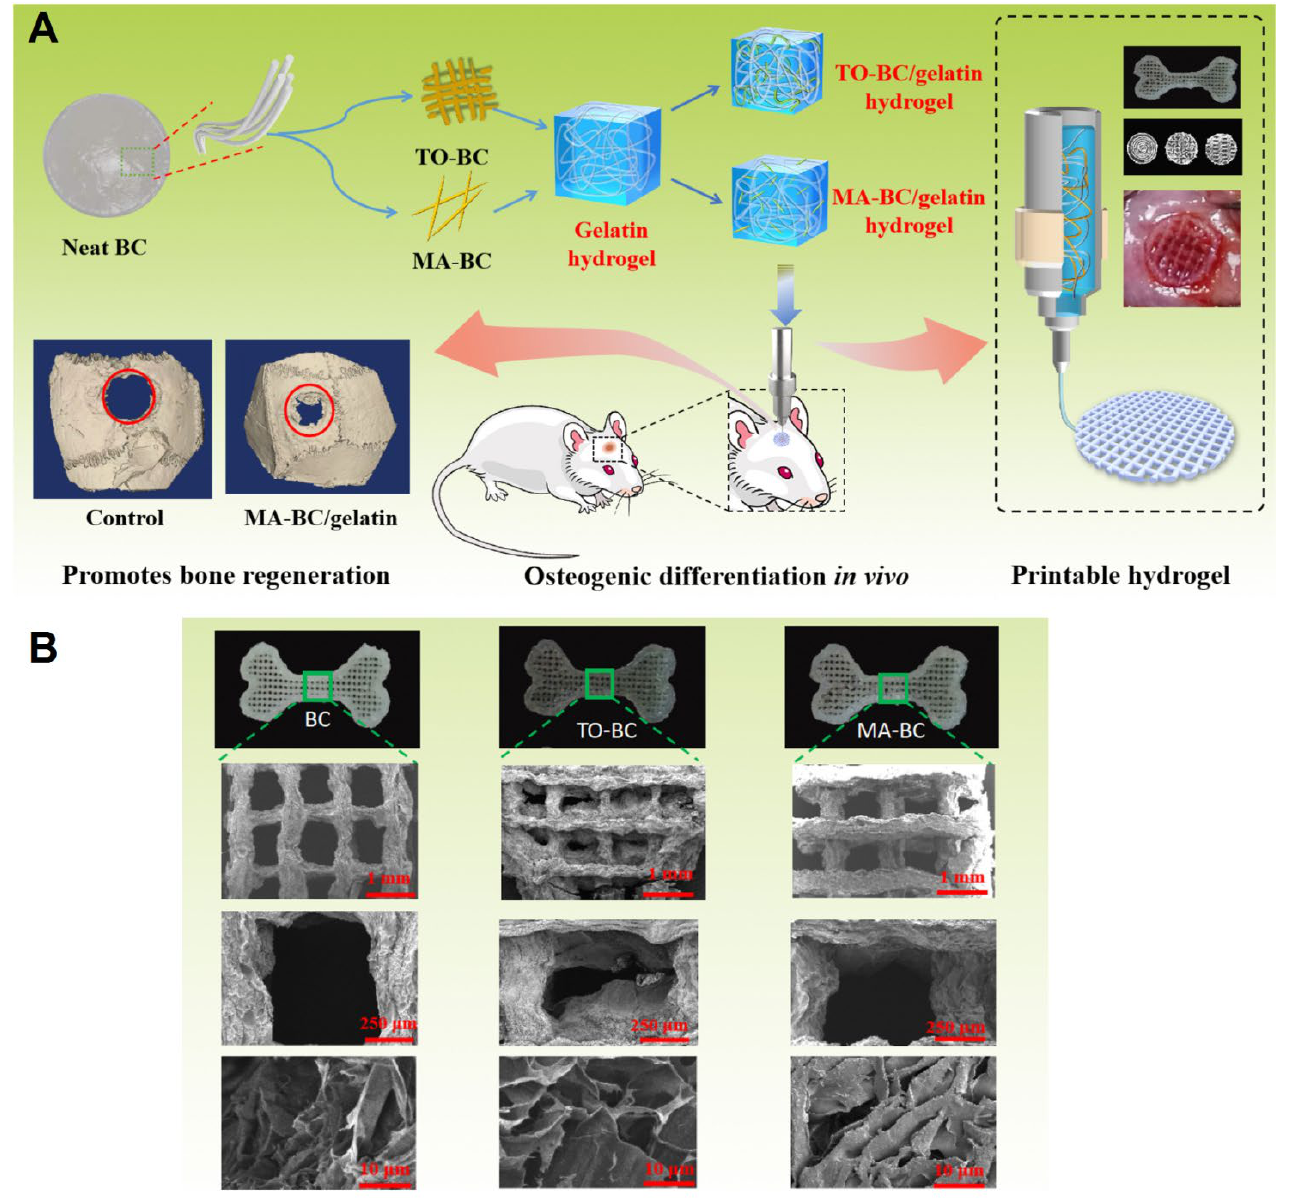
Figure 2. ( A ) The preparative process of printable bacterial cellulose –gelatin gels for osteogenic regeneration (in vivo). ( B ) Scanning electron microscopy (SEM) images of printed scaffolds (BC, TO-BC, and MA-BC). Adapted from reference [74] with permission. Copyright 2021 Elsevier.